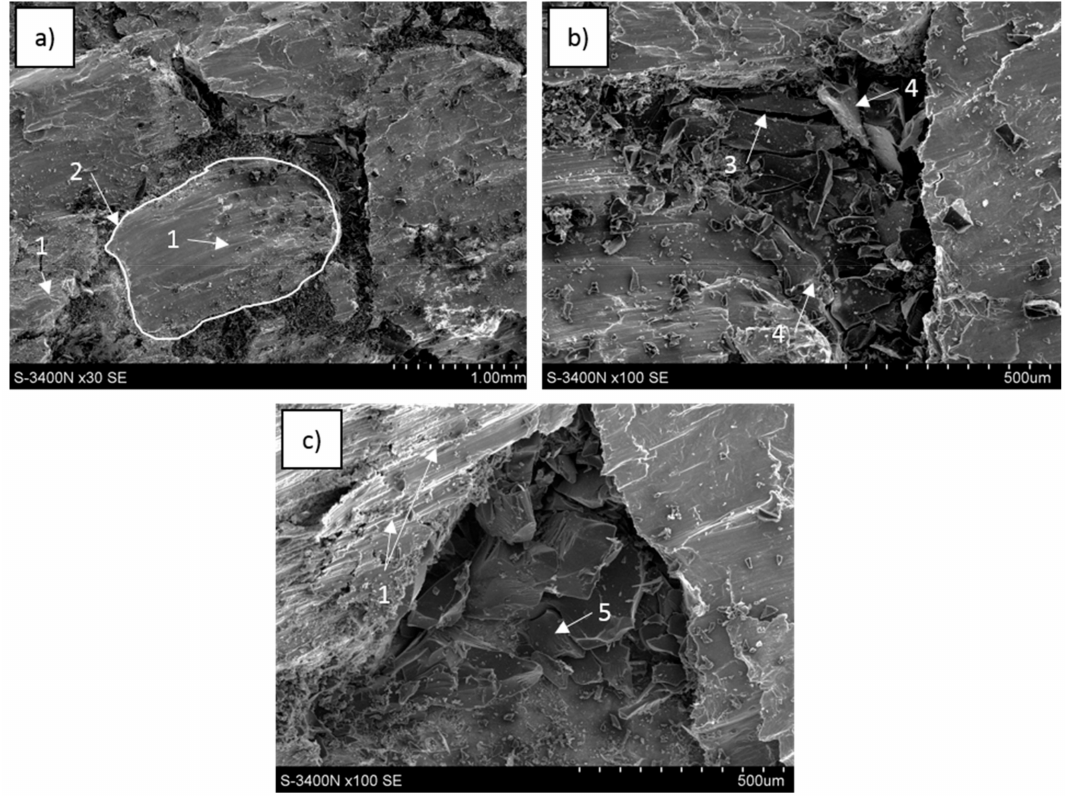
Figure 9. SEM images of C of 20ppi–Mg composite fractured during compression strength testing: ( a ) metal areas with shear bands (1) surrounded with degraded cells of carbon foam (2), ( b ) cracks in carbon foam (3) and area of carbon (4) coated with an oxide layer formed after contact with liquid magnesium, ( c ) shear bands in magnesium matrix and e ff ect of glassy carbon fragmentation by microcracking